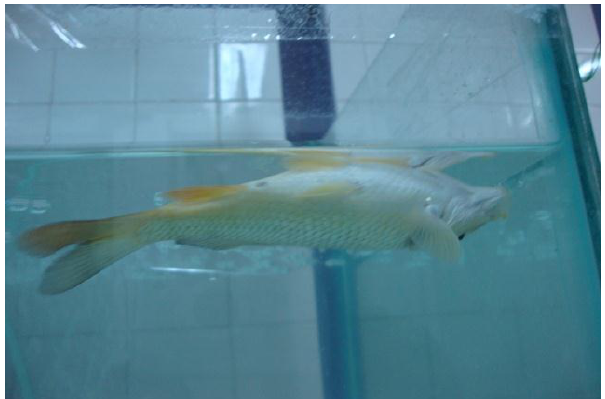
Fig.3: Show imbalance in posture and loss of equilibrium of